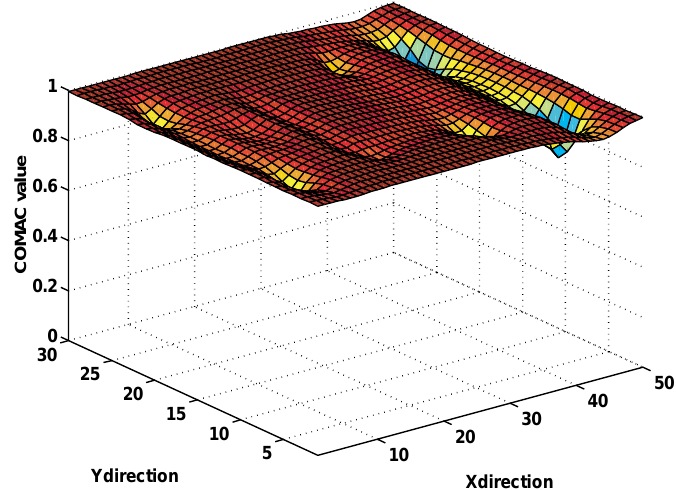
Fig. 9. COMAC values between damaged and undamaged states, for MLE. Only the first six mode shapes are used to calculate the COMAC values.